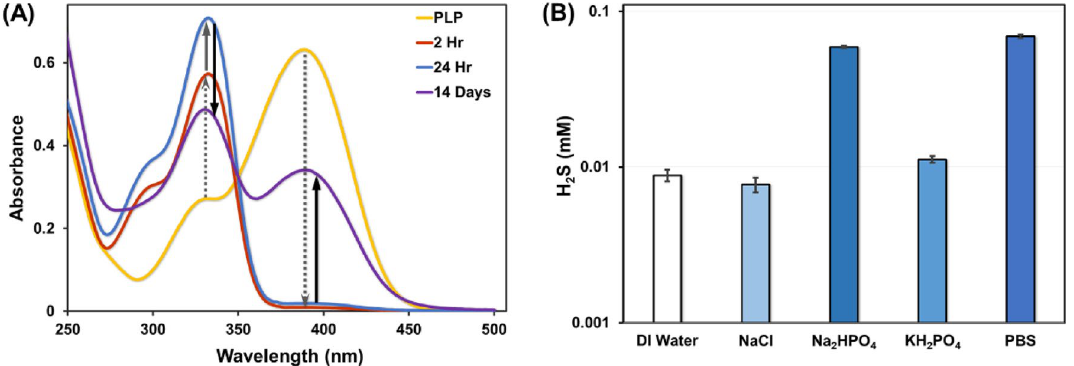
Figure 4. (A) UV–Vis spectrum of the chemical interaction between PLP and cysteine at physiological conditions monitored at 0 h, 2 h, 24 h, and 14 days. (B) H 2 S production from the reaction of PLP and cysteine in DI water, individual components of PBS, and PBS at 37 °C and 24 h. H 2 S production is 9 times more in PBS than DI